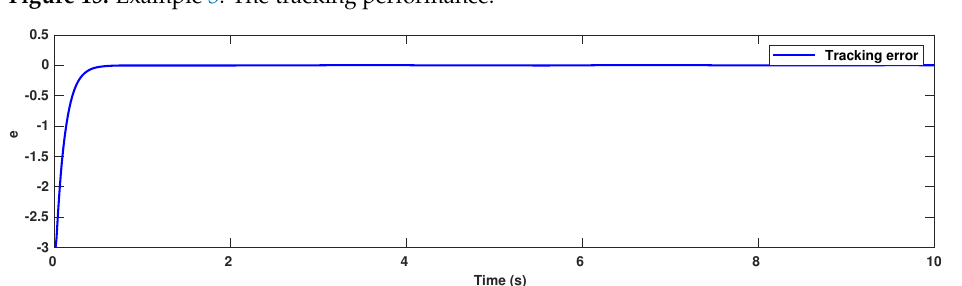
Figure 15. Example 3: The tracking performance.